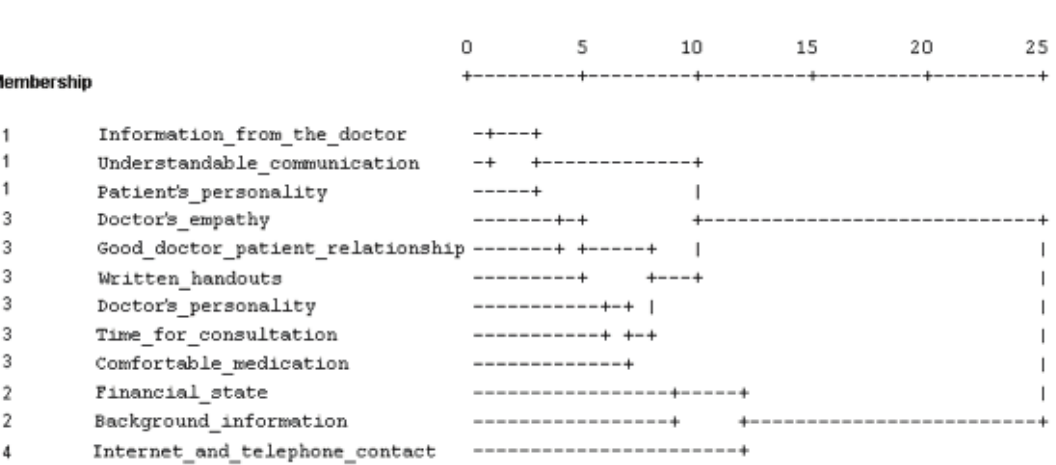
Figure 3: Dendogram from the cluster analysis of chronic skin patients’ answers to the questionnaire, with cluster memberships indicated